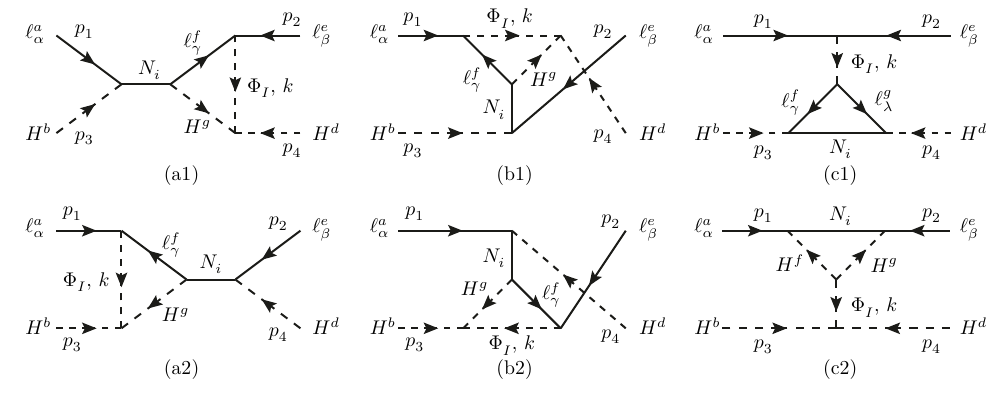
(cid:16) (cid:17) field configuration ‘‘ c e H e H